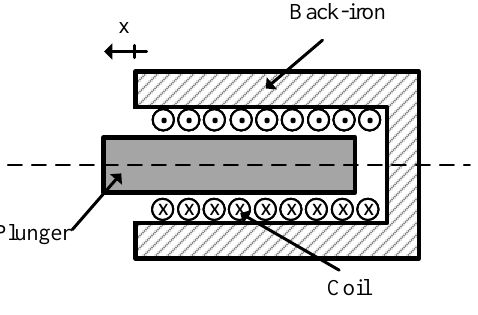
Figure 1. Schematic figure of a solenoid actuator, consisting of coil, plunger and back-iron.